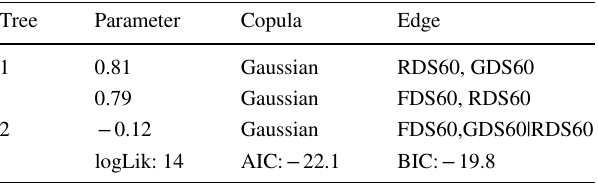
Table 4 Study results of Gaussian R-vine copula for selecting copula function and type of tree in Tapik basin Tree